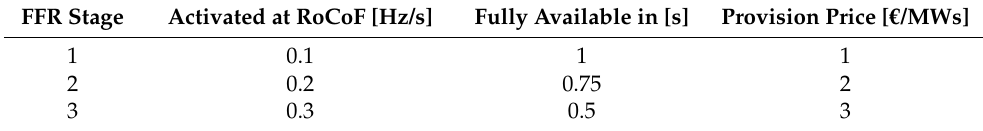
Table 2. Multi-stage FFR parameters.